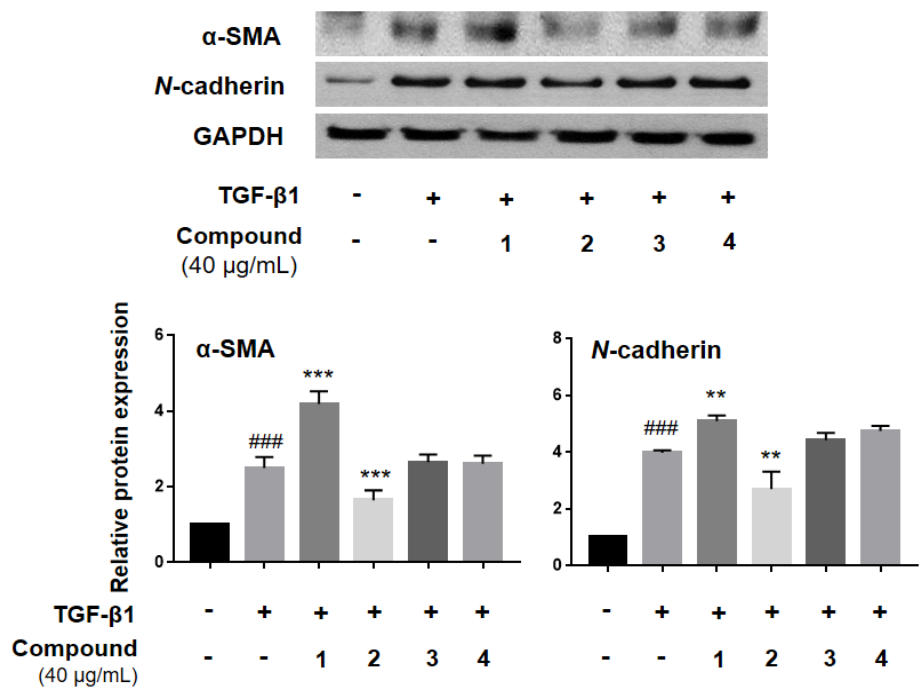
Figure 3. Compound 2 inhibited TGF-β1-induced myofibroblast differentiation in alveolar epithelial A549 cells. A549 cells were treated with TGF-β1 (2 ng/mL) and isolate compounds (40 µg/mL) for 48h. The protein expression of α-SMA and N -cadherin was analyzed by western blot. All the assays were performed in triplicate, and the data are shown as the mean value ± S.D. Values that are significantly different from the control are indicated by ### p < 0.001, and values that are significantly different from the TGF-β1-treated group are indicated by ** p < 0.01, and *** p < 0.001.